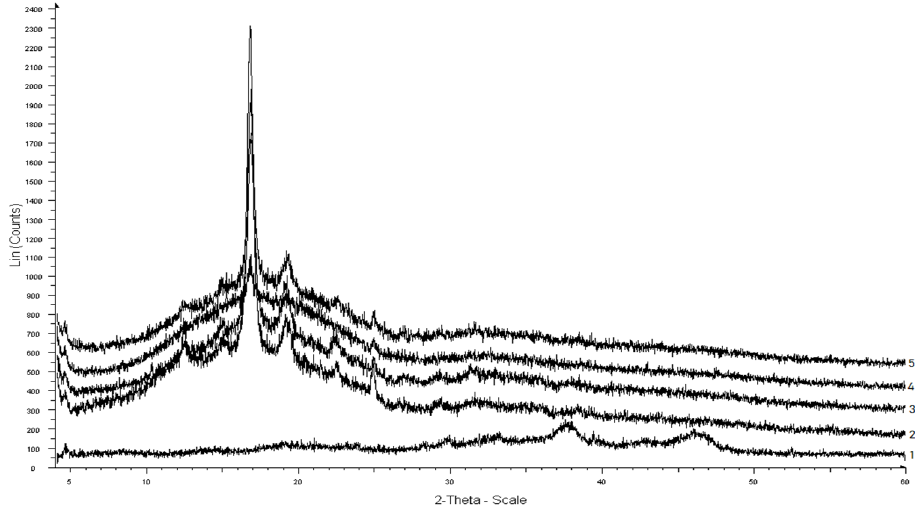
Figure 3. X-ray diffraction patterns of PLA (1) and PLA/AONF composite films with different AONF content: 2—0.1%, 3—0.2%, 4—0.5%, 5—1%.